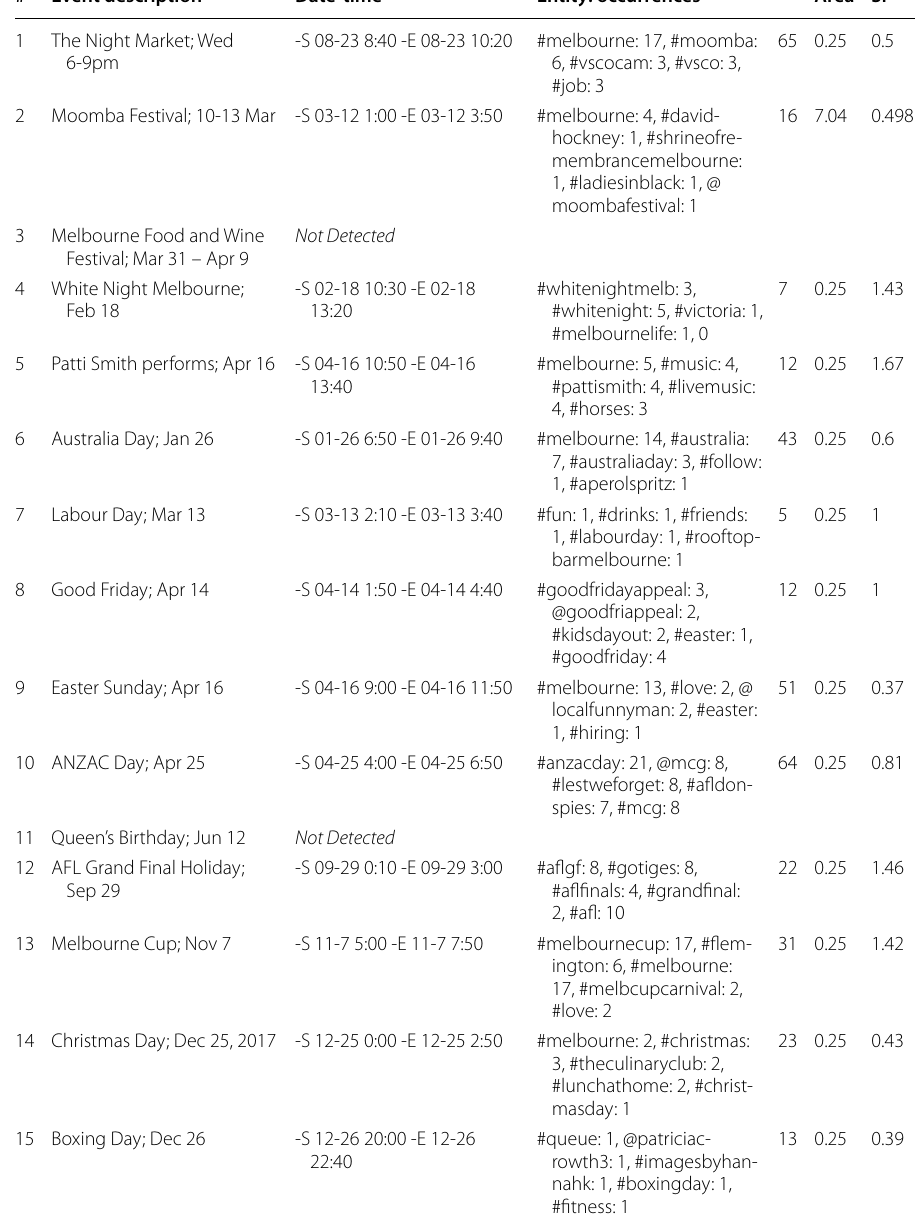
Table 11 Recall results for clustering based event detection: Melbourne common events occurred in